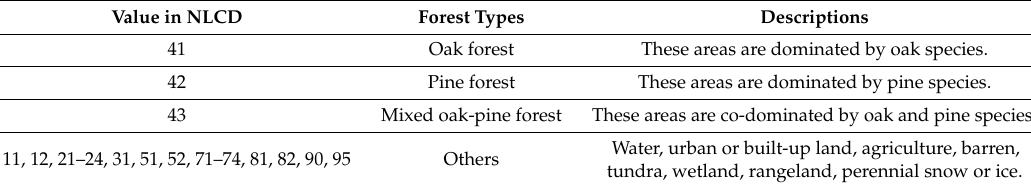
Table 1. The classification scheme of forests in this study. This classification system is modified from the Anderson Land Cover Classification System and is based on species composition in western Central Hardwood Forests.